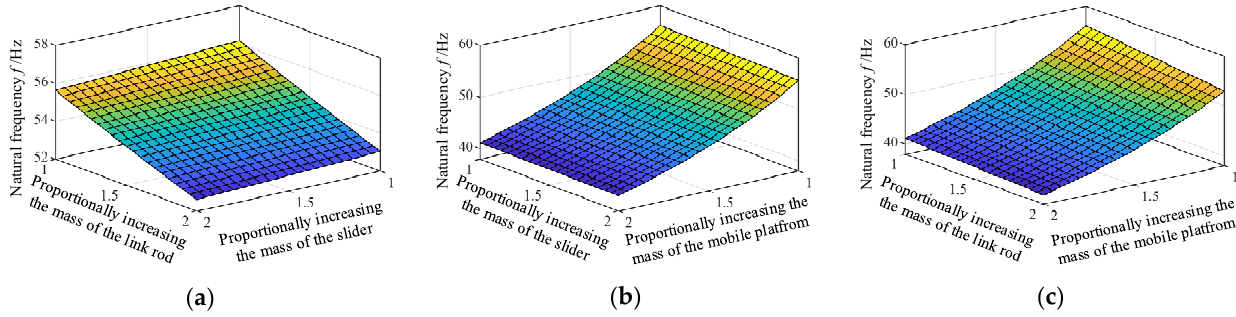
Figure 6. The influence of the variation of the mass proportional of different components on the natural frequency. ( a ) Proportionally increasing the mass of the link rod and the slider. ( b ) Proportionally increasing the mass of the slider and mobile platform. ( c ) Proportionally increasing the mass of link rod and mobile platform.